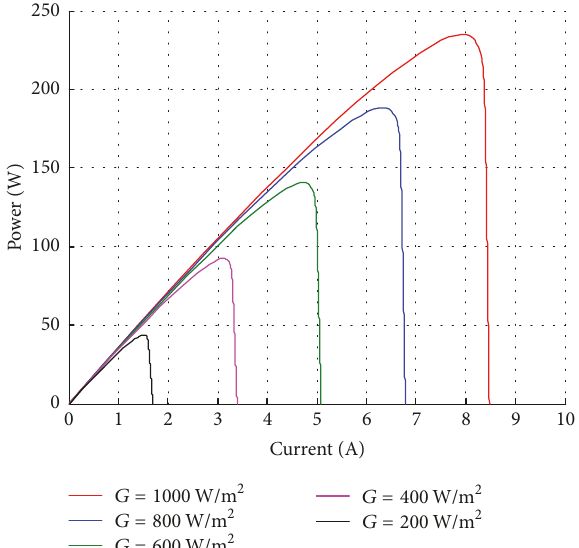
Figure 7: 𝑃 - 𝐼 curves for different solar irradiation.